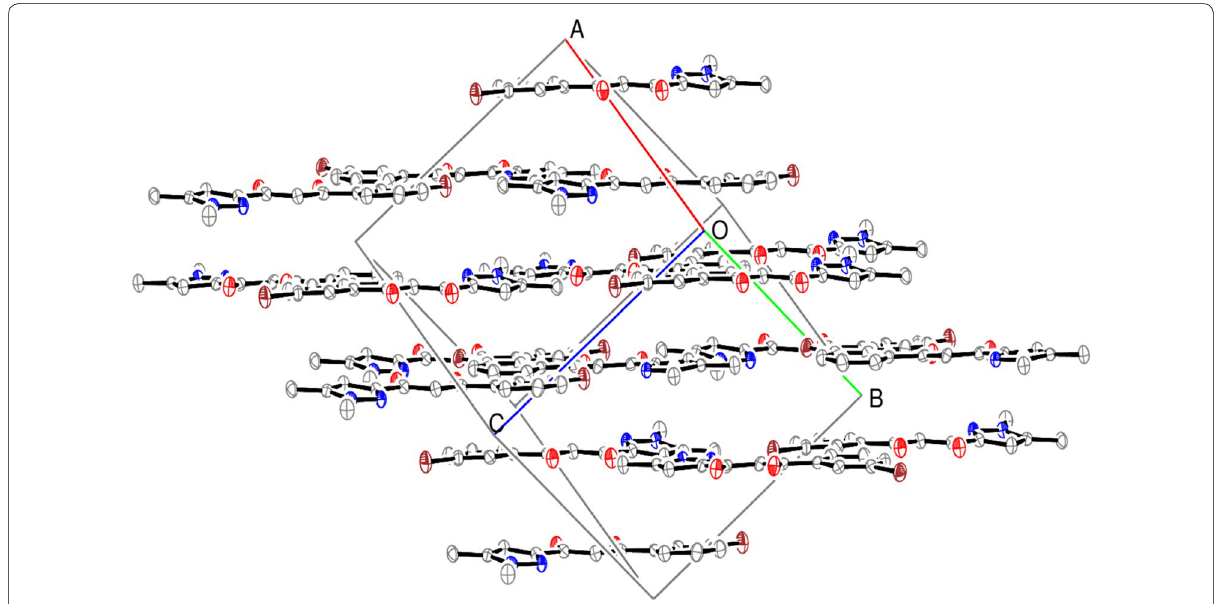
Fig. 2 Molecular packing in the triclinic lattice enhancing the peculiar layered arrangement of molecules in planes parallel to ( 1 ¯ 1 ¯ 1